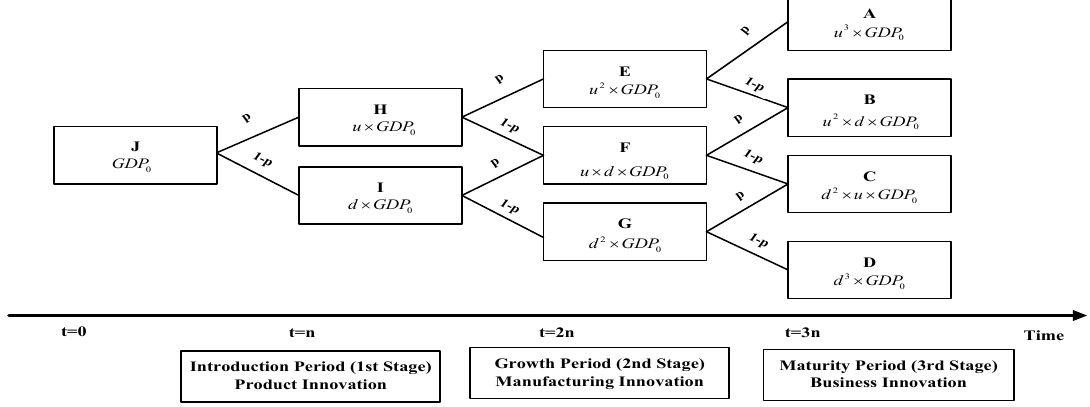
Figure 1. Gross Domestic Product (GDP) change path.